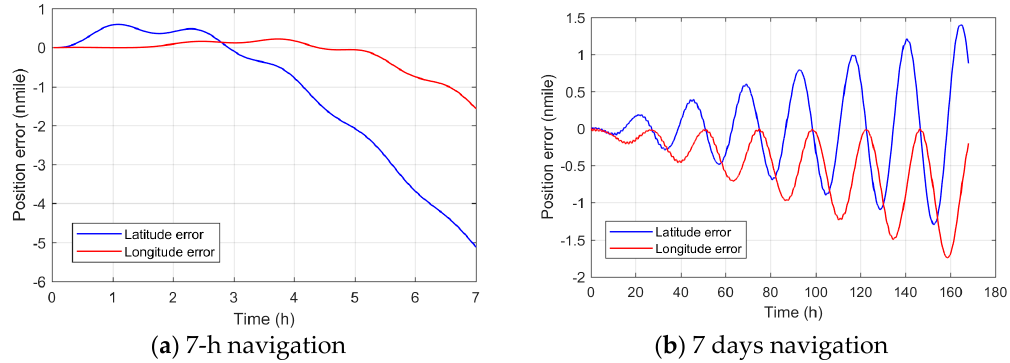
Figure 6. Position error in numerical simulation based on semi-physical data.